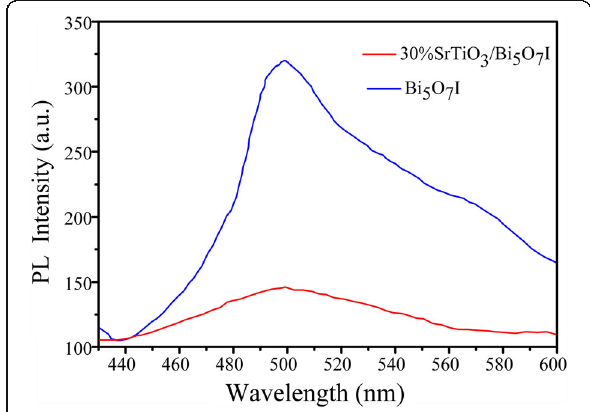
Fig. 8 PL spectra of pure Bi 5 O 7 I nanosheets and 30 wt% SrTiO